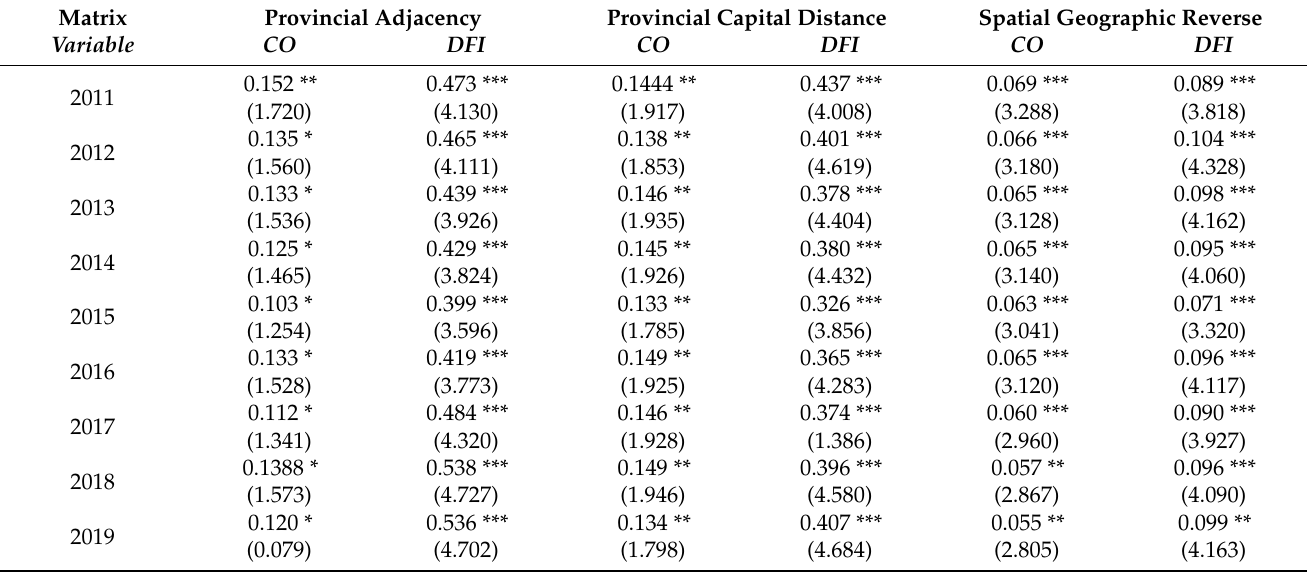
Table 1. Moran index